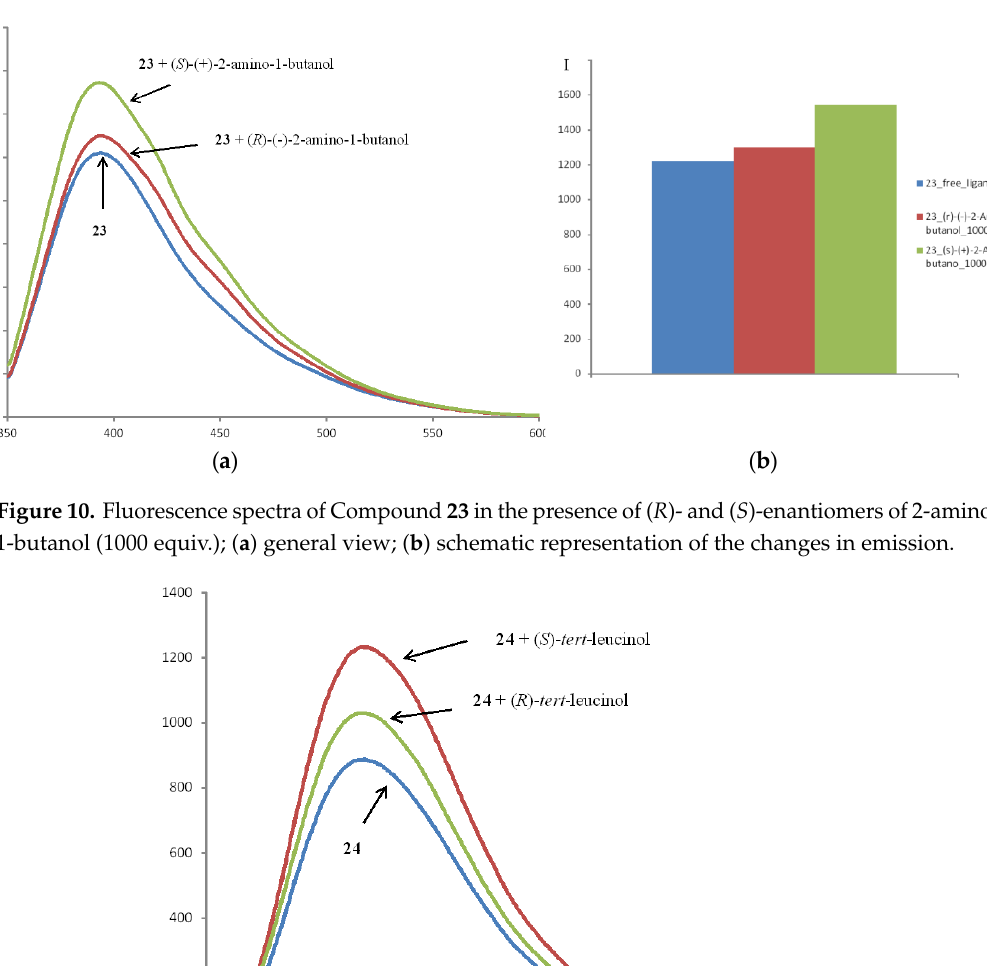
Figure 9. Fluorescence spectra of compound 22 in the presence of ( R )- and ( S )-enantiomers of 2-phenylglycinol (1000 equiv.); ( a ) general view; ( b ) schematic representation of the changes in emission.